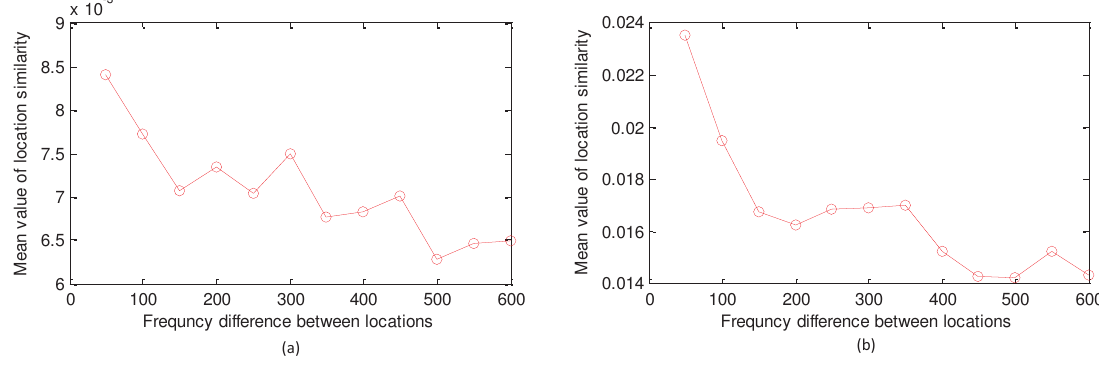
Figure 3. Relationship between frequency difference and POI similarity in the ( a ) Gowalla and ( b ) Brightkite datasets.